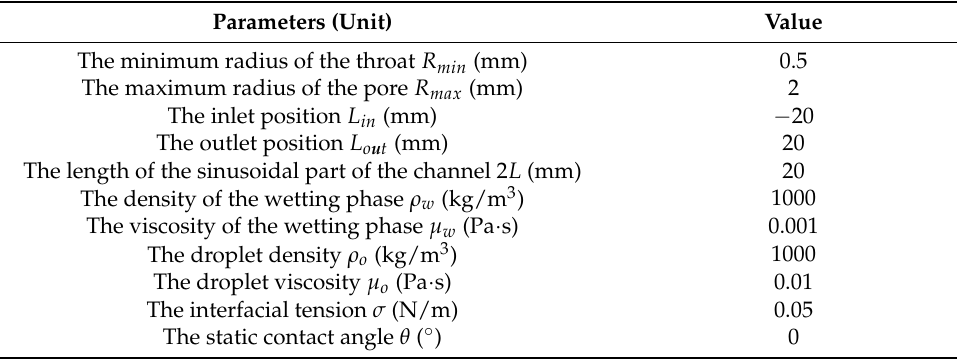
Table 2. Geometric parameters and flow properties used in simulations. Parameters (Unit) Value The minimum radius of the throat R min (mm) 0.5 The maximum radius of the pore R max